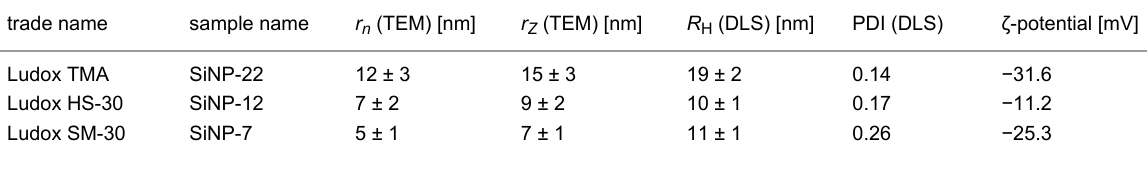
Table 1: Average radius and ζ -potential of the SiNPs as determined by TEM, DLS and electrophoretic mobility measurements, respectively. TEM statistics are based on the measurement of at least 1500 individual